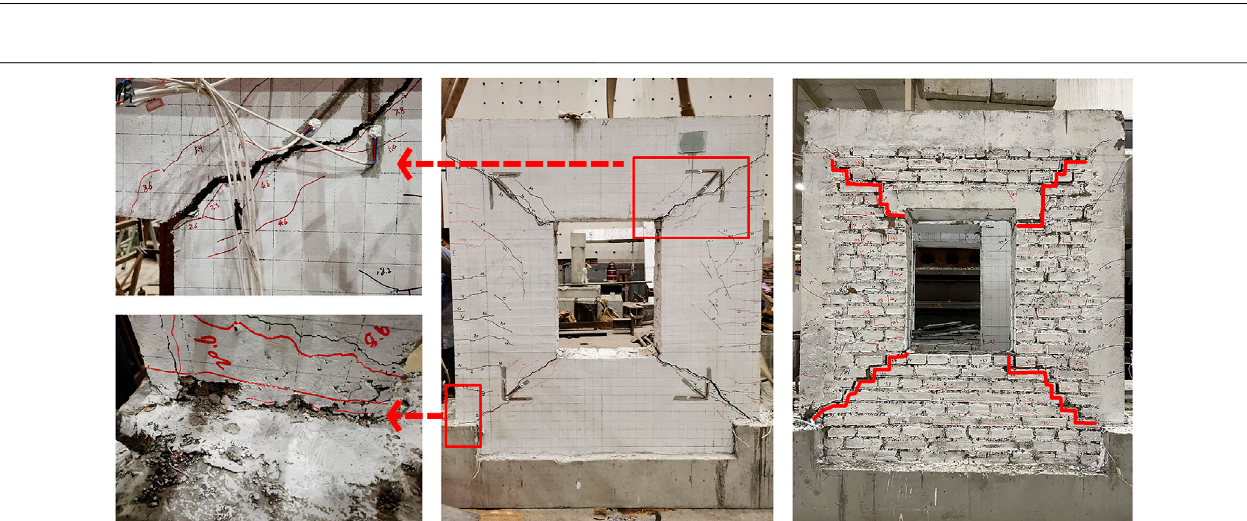
FIGURE 6 | Failure mode and crack pattern for SRMW-2 at ultimate